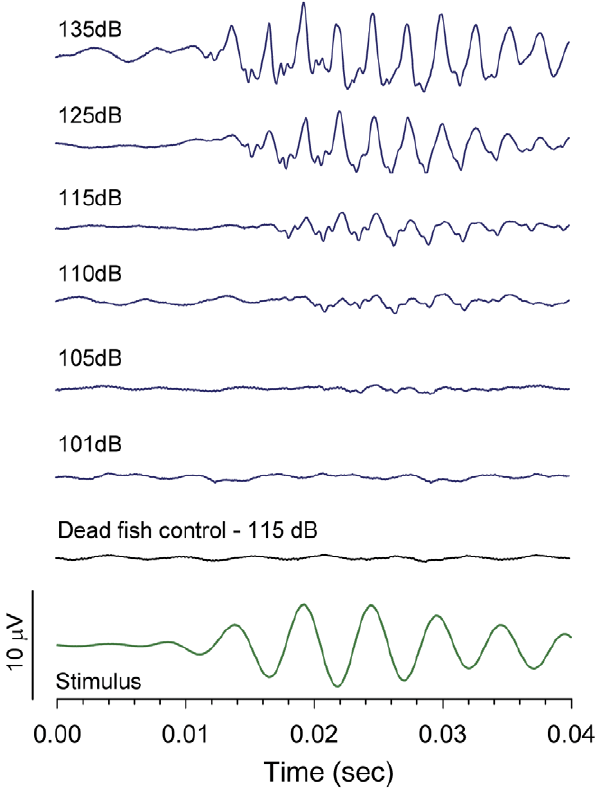
Figure 4. Example of auditory evoked potential (AEP) traces recorded from A.burtoni . Averaged AEP traces from a representative subordinate male in response to a 200 Hz stimulus at several different intensities. An averaged trace from a control dead fish at 120 dB in response to a 200 Hz stimulus shows no response. Bottom trace shows the actual stimulus waveform recorded by the hydrophone at the position of the fish head. Threshold at this frequency was 105 dB rms re: 1 m Pa based on the repeatable waveform and the presence of an FFT peak at twice the stimulus frequency.